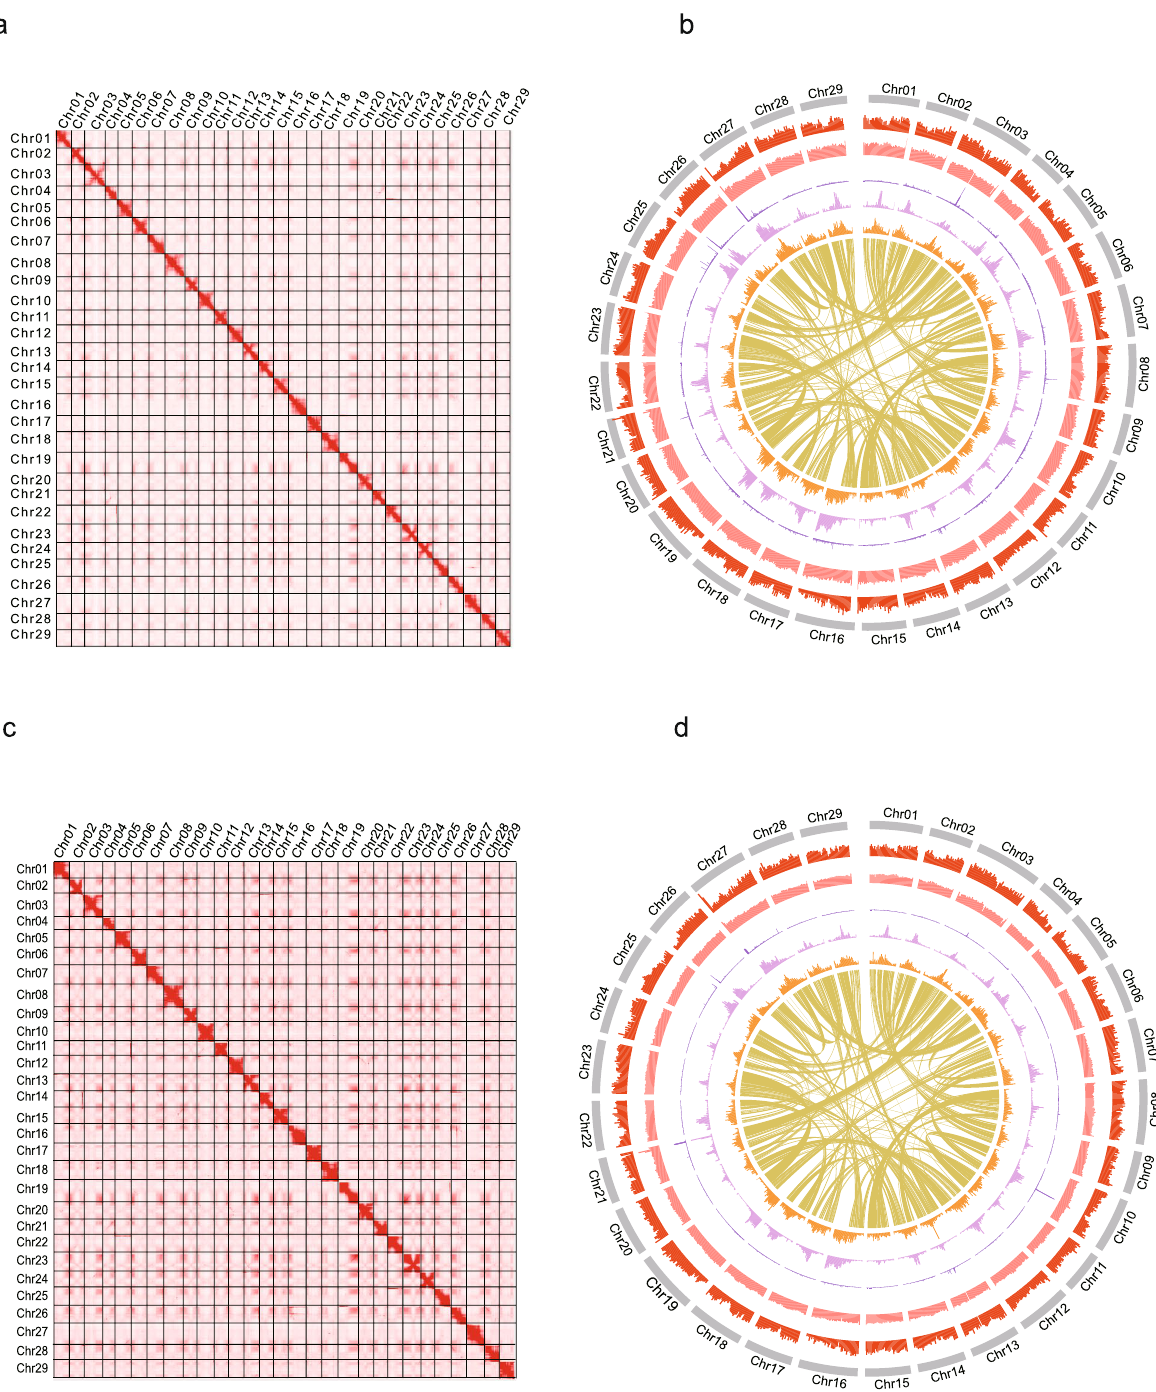
C interactions of MDHAPA ( a ) and MDHAPB ( c ); −